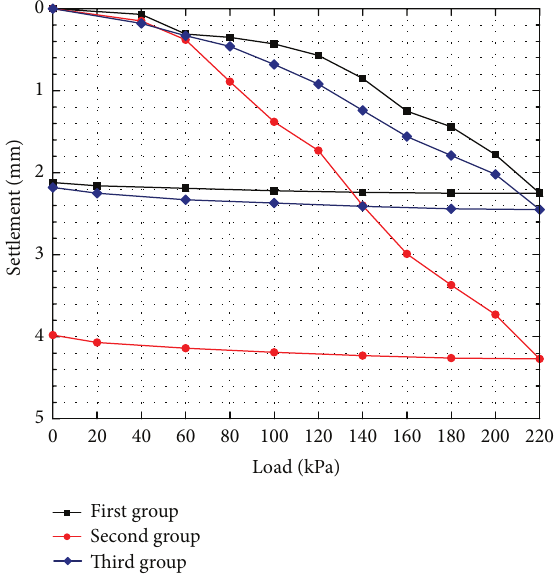
Figure 7: The 𝑃 - 𝑆 curve of soil among